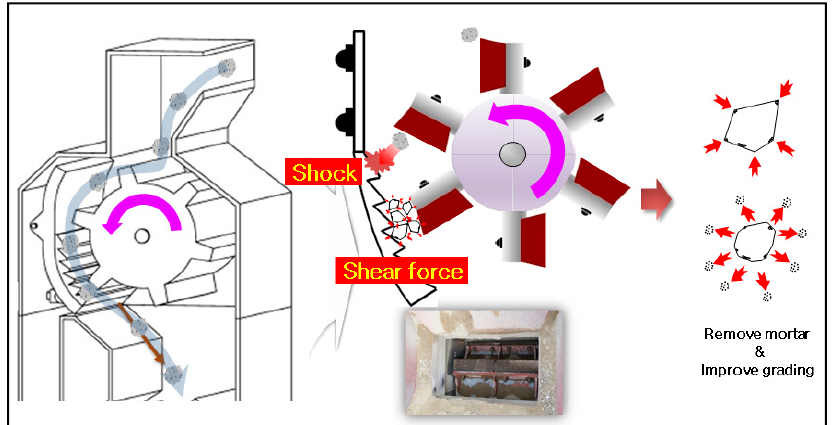
Figure 5. The principle of mortar removal.